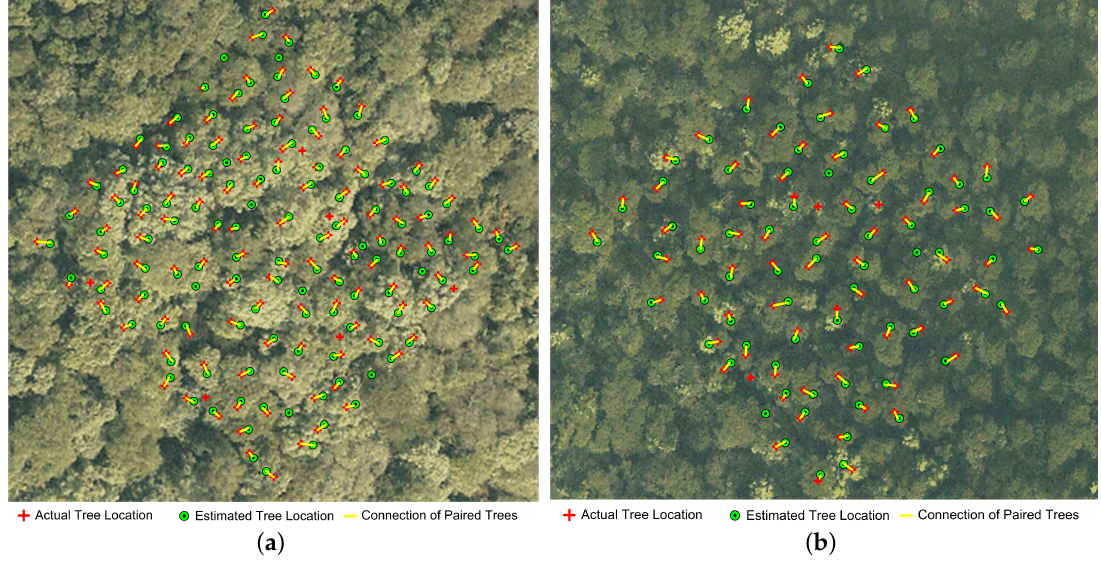
Figure 9. Matching of the reference tree positions and the estimated positions for two different test subplots. ( a ) A dense single-tree species dominated subplot (DHS0602). ( b ) A sparse multi-tree species dominated subplot